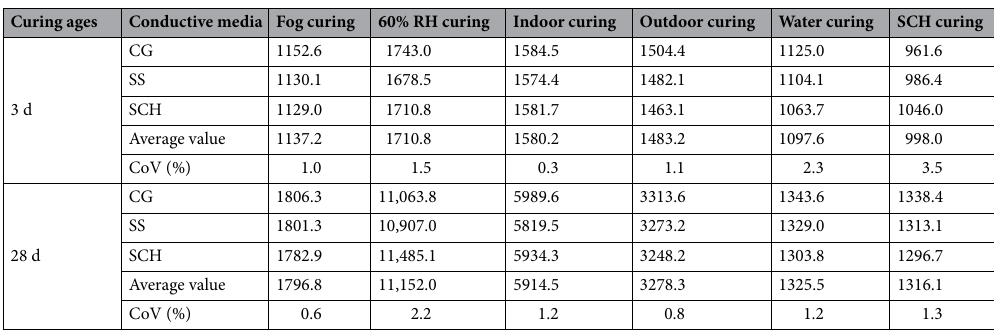
Table 3. Modulus values of ACIS measured by the four-point measurement under different curing conditions ( L / a = 2). CoV means variation coefficient of test results of three samples measured from the four-point measurement with three conductive